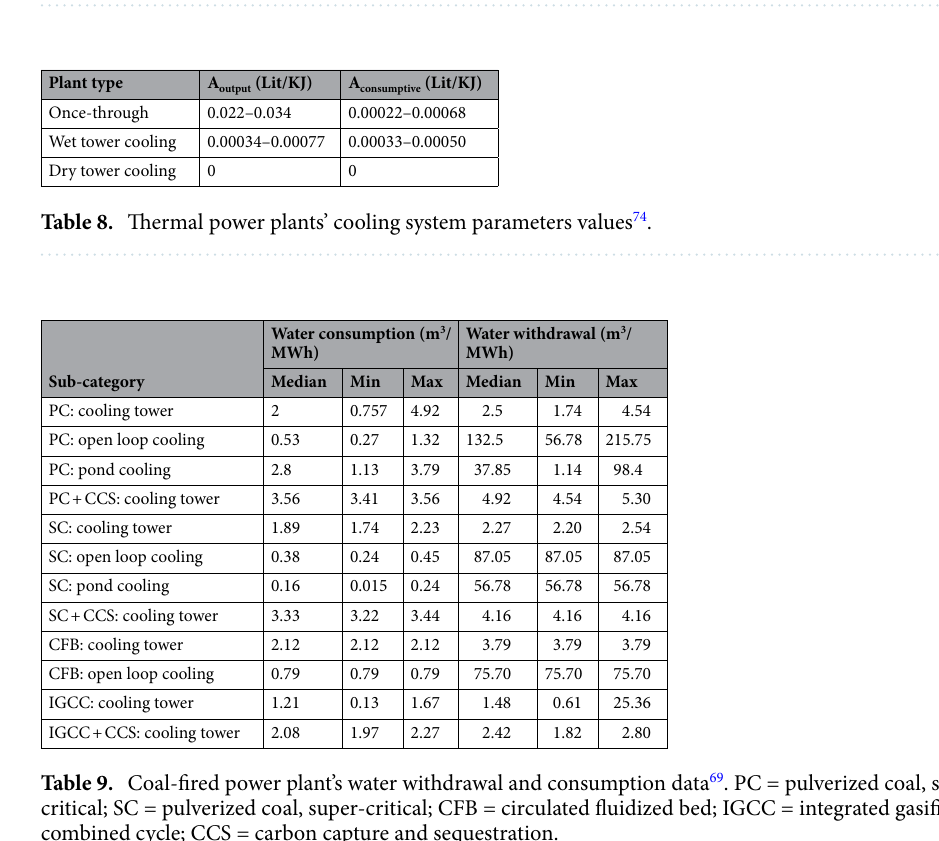
Table 7. Thermal power plants’ parameters value 74 .